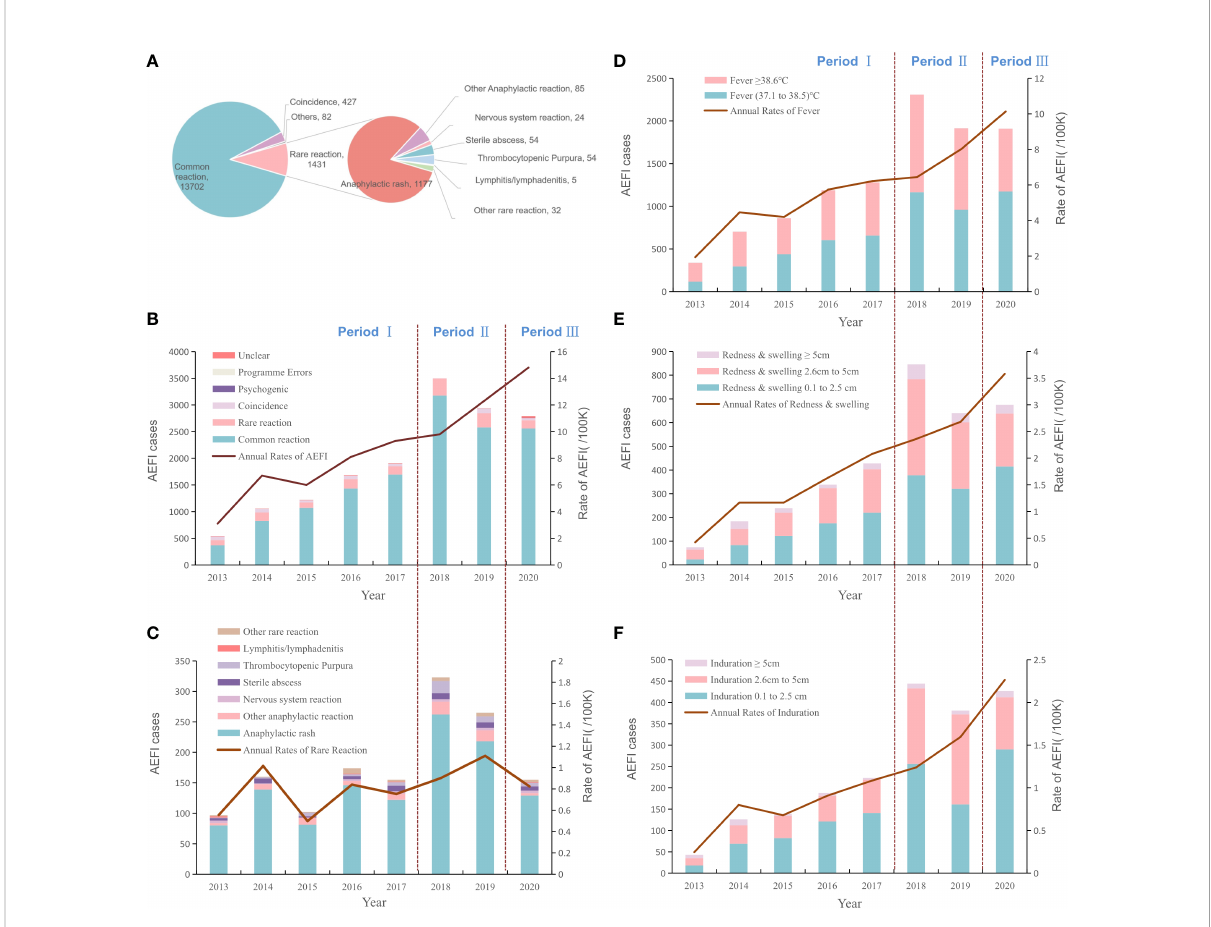
FIGURE 1 The proportion of reported AE cases and rates of adverse events after HepB immunization by years and reaction categories. (A) . The proportion of total AEFIs after HepB immunization and the composition of the rare reactions (B) . The dynamic changes of total rates and proportions of AEFIs following HepB by year (C) . The dynamic changes of rates and proportions of rare reactions following HepB by year (D) . The dynamic changes of rates and proportions of fever following HepB by year (E) . The dynamic changes of rates and proportions of redness & swelling following HepB by year (F) . The dynamic changes of rates and proportions of induration cases following HepB by